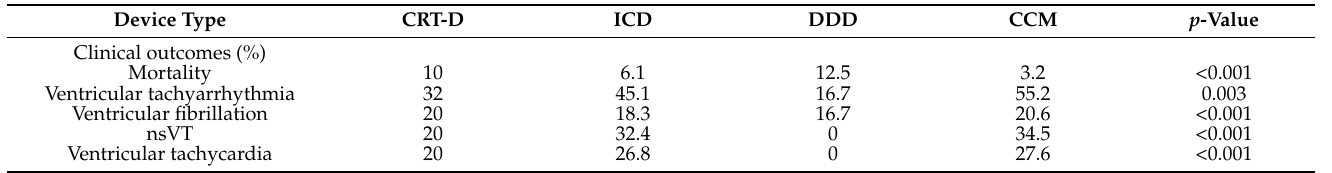
Table 4. Predictors for Table 3. Device therapy and the impact on the outcome.